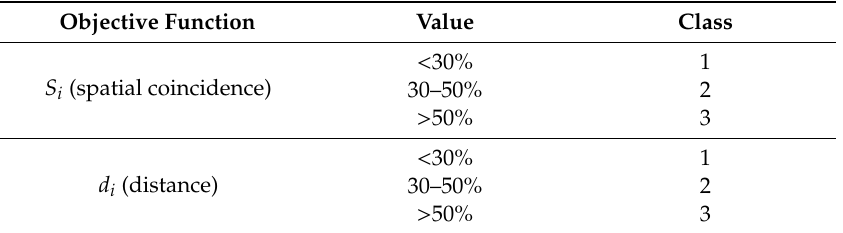
Table 3. Classification criteria of objective functions for the decision trees